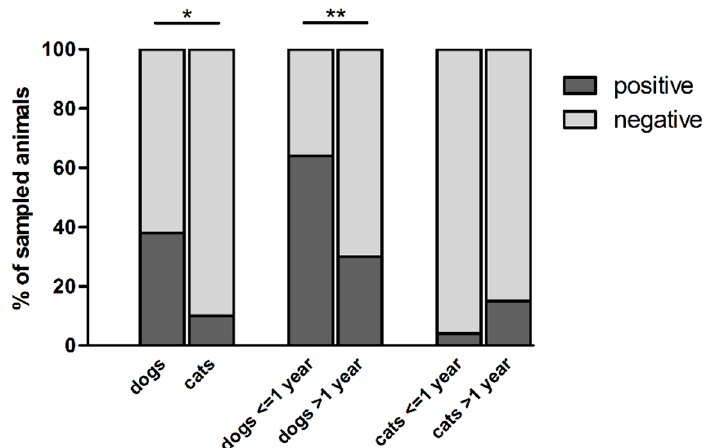
Figure 1. Carriage of thermophilic Campylobacter spp. in pets from France. * represents the significant di ff erence between Campylobacter spp. carriage by dogs and cats (Fisher test, p < 0.0001); ** represents the significant di ff erence between Campylobacter spp. carriage by dogs ≤ 1-year-old and older dogs (Fisher test, p < 0.0001).